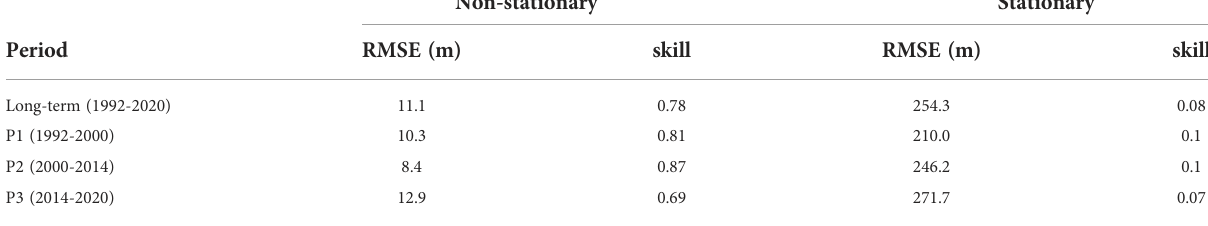
TABLE 1 Summary statistics of the stationary and non-stationary approaches for different time